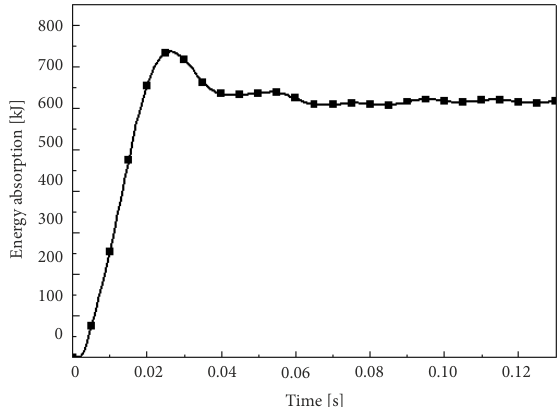
Figure 17. Energy absorption characteristic curve of the vehicle